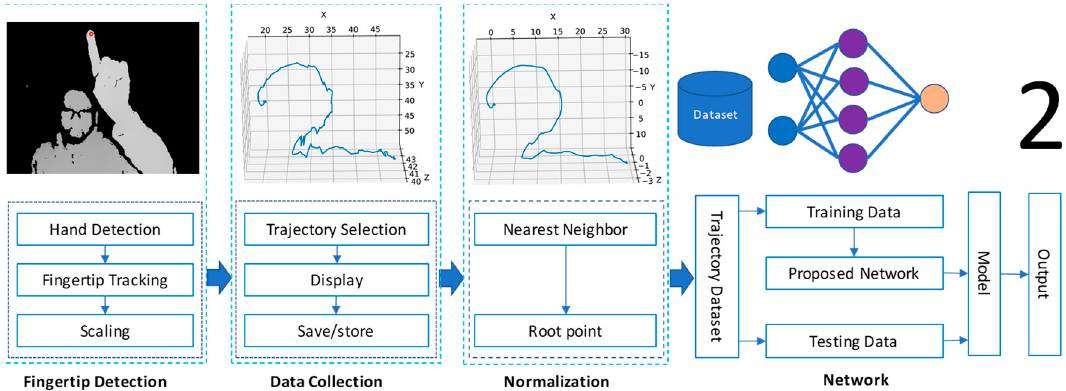
Figure 1. Block diagram for the proposed method including the fingertip detection, data collection, normalization, and network design.